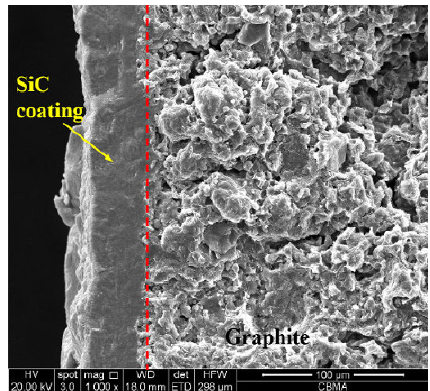
Fig. 8 Cross-section micrograph of the SiC coated graphite.